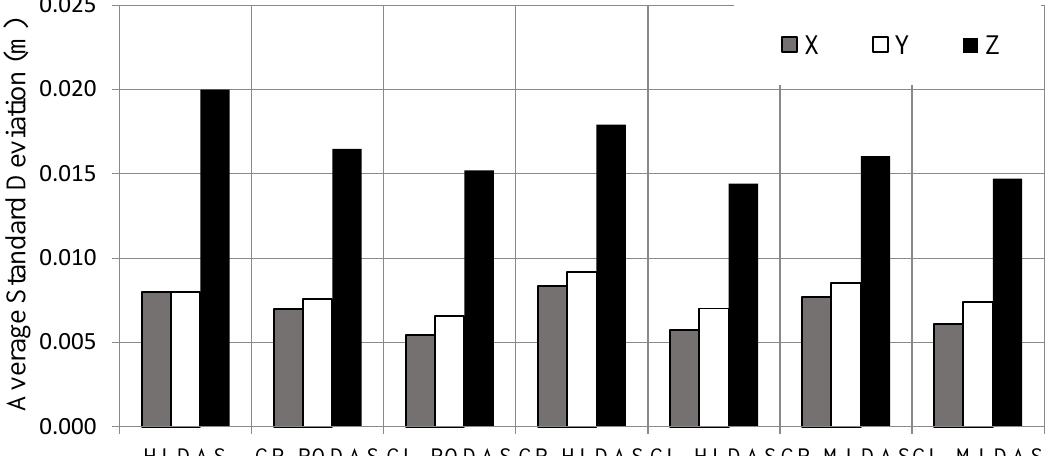
Figure 6. Average post-adjustment standard deviations for positional components of georeferencing parameters for the Site 1 dataset. Standard deviations were extracted from the a posteriori covariance matrix shown in Equation